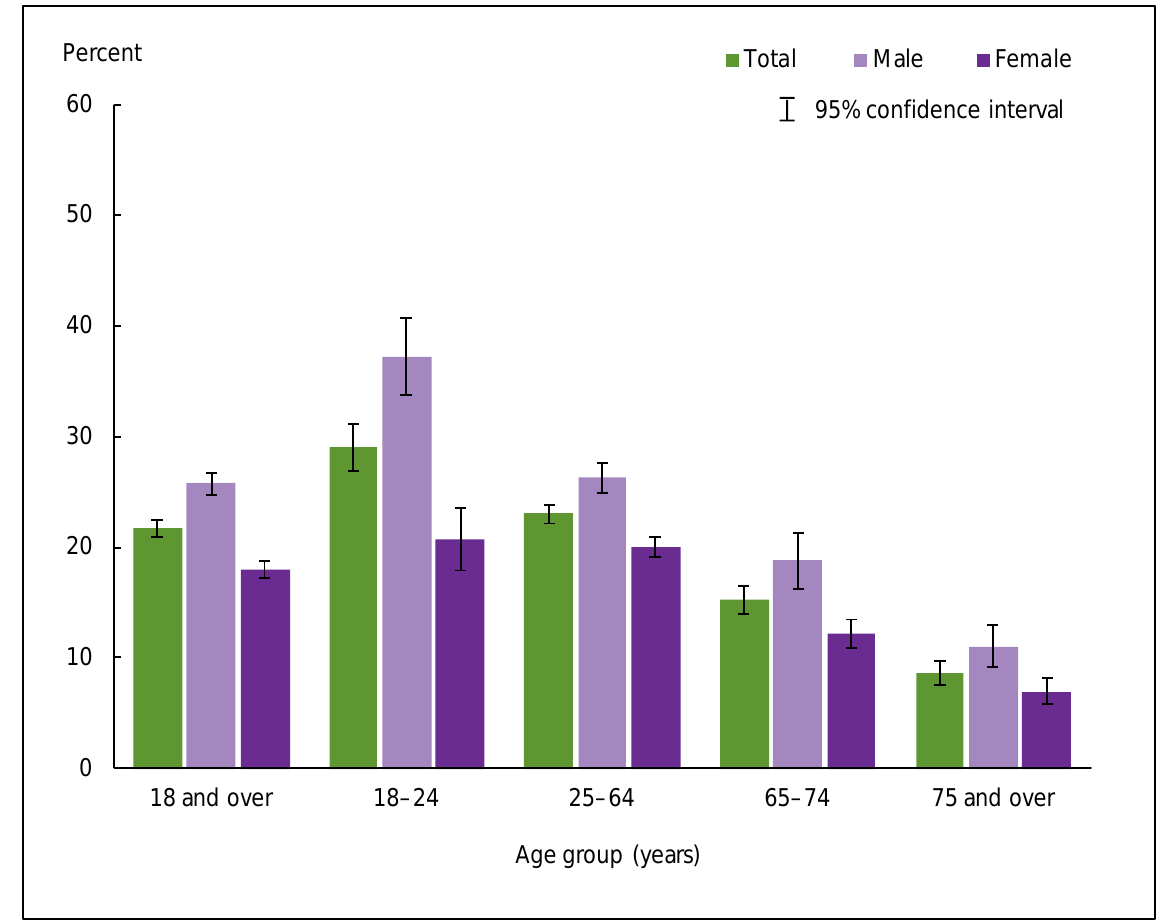
Figure 7.5. Percentage of adults aged 18 and over who met 2008 federal physical activity guidelines for both aerobic and muscle-strengthening activities through leisure-time aerobic and muscle-strengthening activities, by age group and